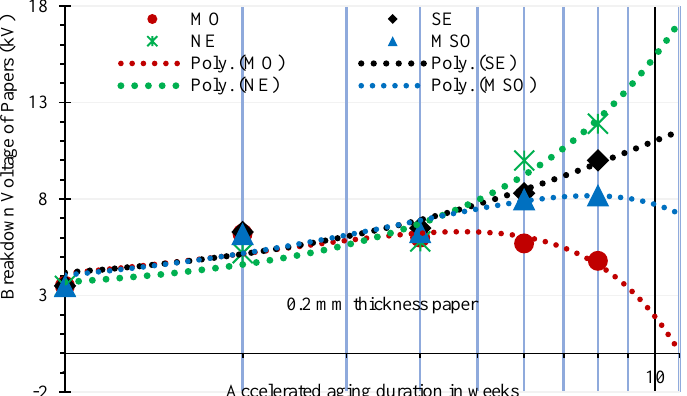
Figure 12. Expectance of BDV for 0.2 mm thickness paper with the diffusion of various insulating oils with thermal stressing.